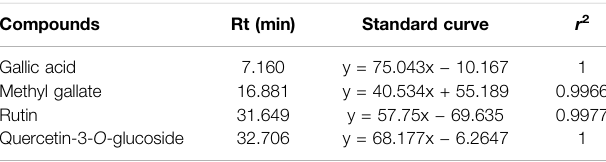
TABLE 5 | Retention times (Rt), standard curve and r 2 values of phenolic compounds. Compounds Rt (min) Standard curve